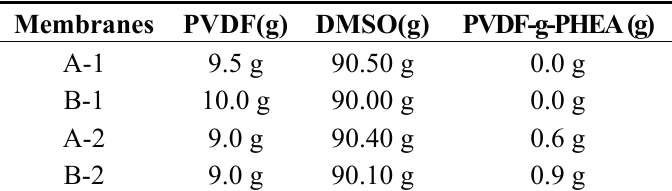
Table 1. Membrane